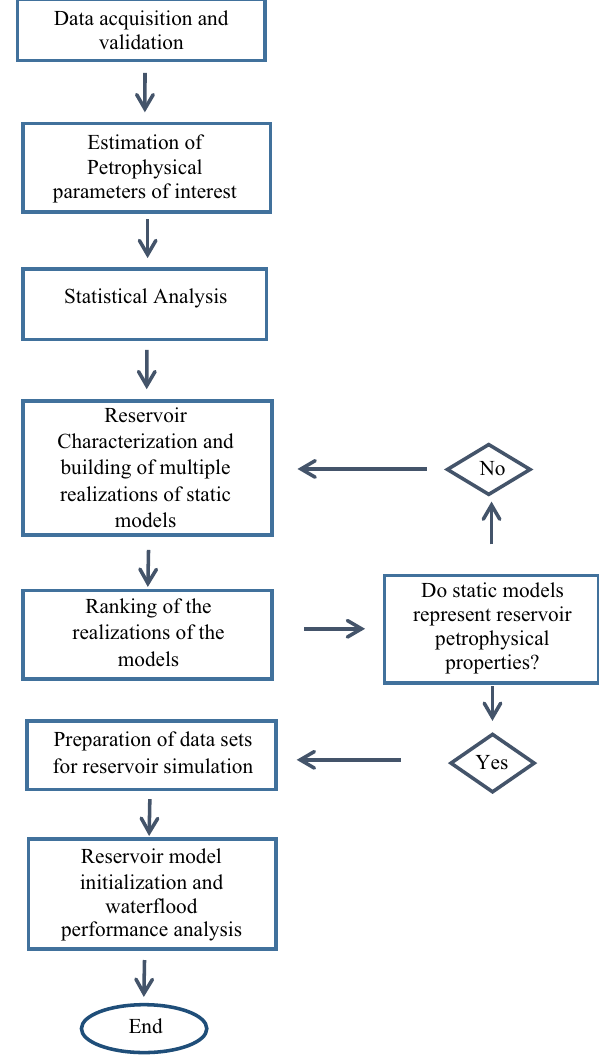
Fig. 1 Flowchart for